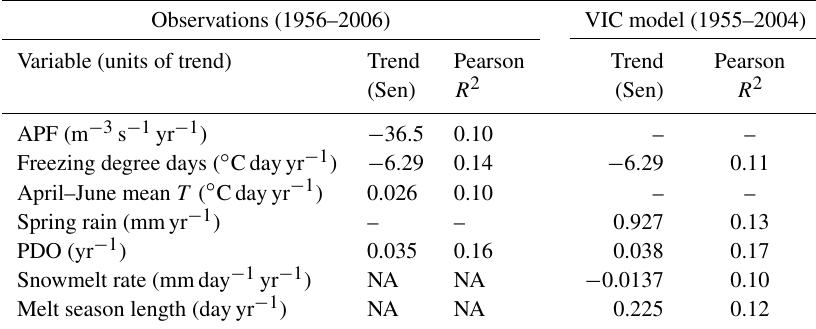
Table 3. Trends in observed and VIC-simulated variables over the period of each record. Results are only shown for those variables that contain a statistically significant trend at the p < 0.05 level. The trend was calculated using the Theil–Sen median slope estimator (Sect. 2.3). Slightly different results are obtained for observed inputs to the VIC model due to the difference in start and end years of the time series. The residuals of each fit were checked for autocorrelation, with none detected. NA indicates this info is not available in the observations we